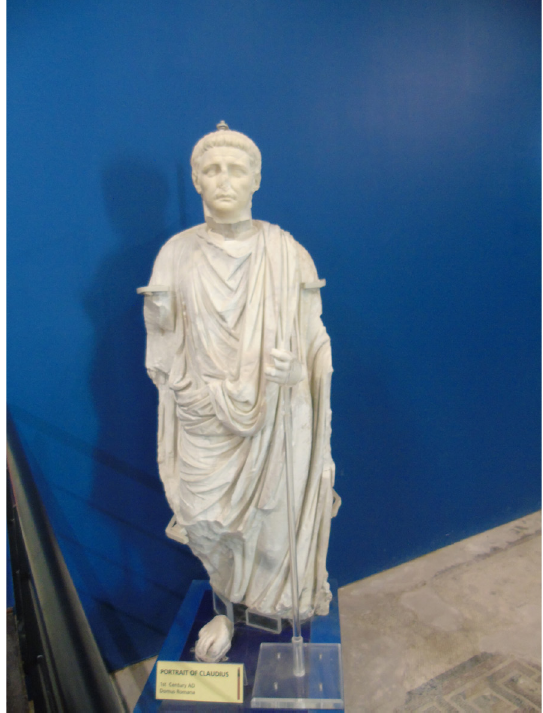
Figure 5: Statue of the Emperor Claudius from the Domus Romana (Photo: author, courtesy of Heritage Malta).